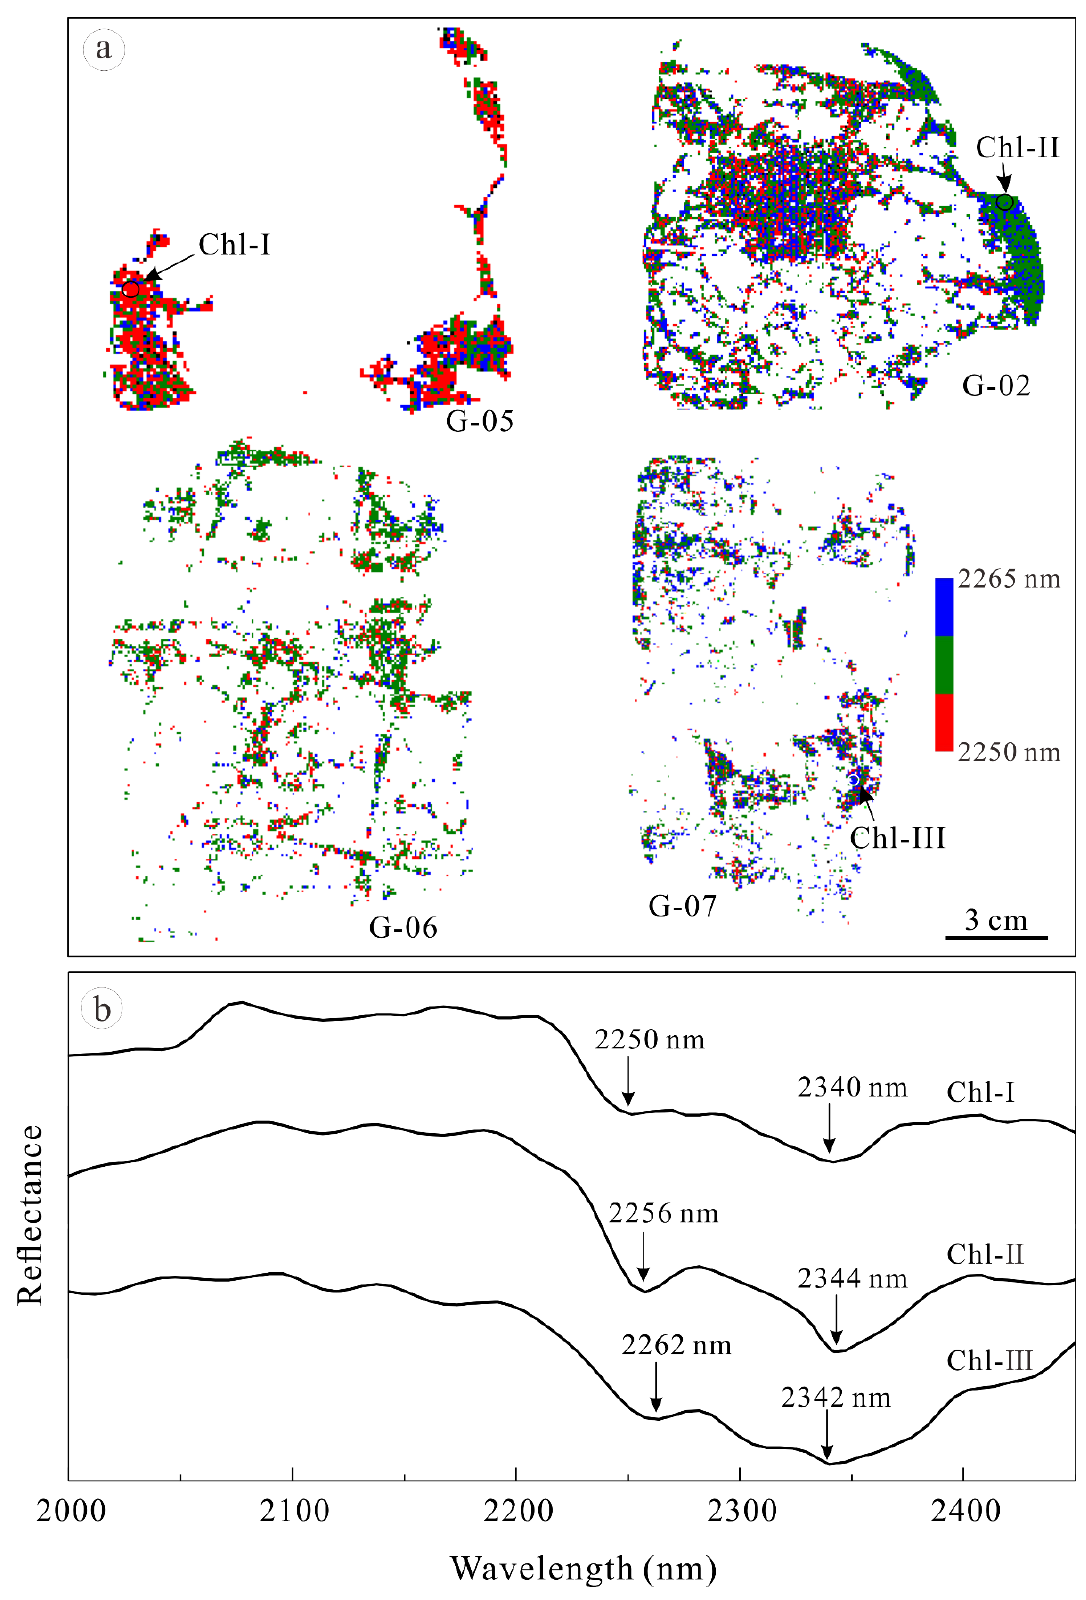
Figure 2. Result of mapping mineralogy from Hyspex hyperspectral images. ( a ) Map of chlorite spectral wavelength position at 2250 nm by Fe-OH, the circles point out the location of single spectrum in Figure 2b. ( b ) The single spectrum of three types of chlorites in the Gongchangling deposit.